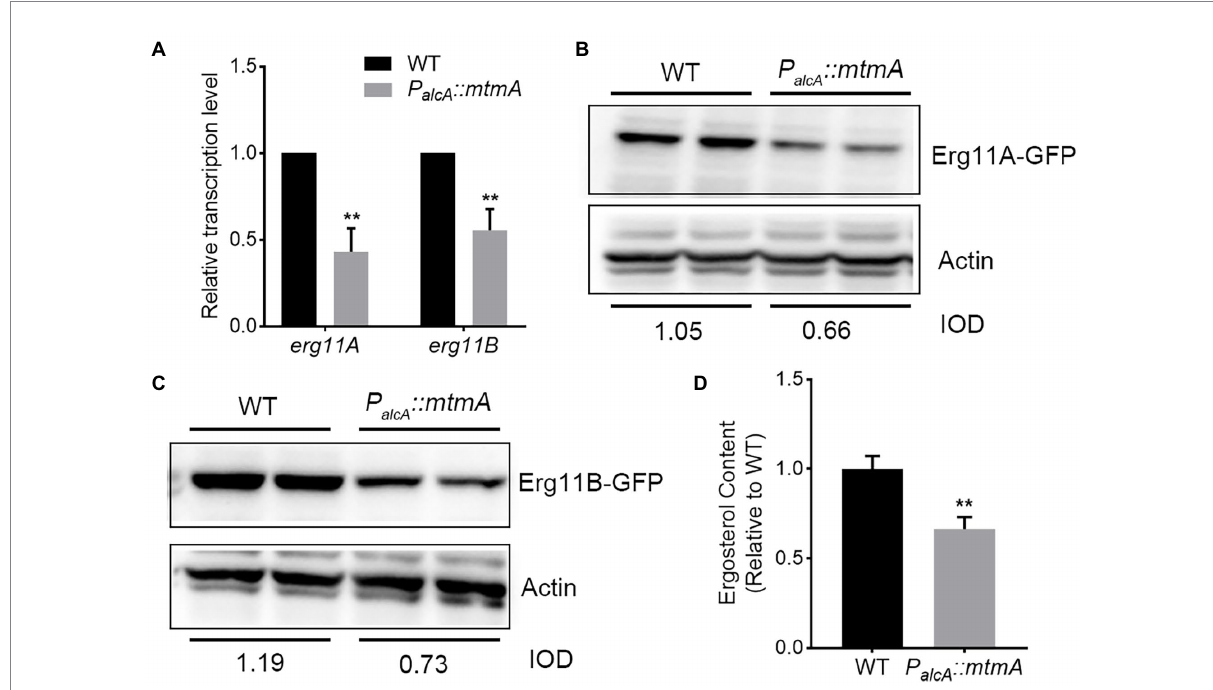
FIGURE 2 MtmA is required for the expression of Erg11A/B. (A) The transcript levels of the indicated genes in WT and the mtmA -repressed strains grown at 37 ° C for 24 h under MM + glucose inhibition culture conditions. Error bars indicate the mean ± SD of the results from three independent experiments. Statistical significance was determined by Student’s t test. **, p < 0.01. (B,C) Western blot analysis of the expression of Erg11A and Erg11B in the parental wild-type and mtmA -repressed strains under MM + glucose inhibition culture conditions. Actin was used as the loading control. The value of the integrated optical density (IOD; IODtarget protein/IODactin) measured by ImageJ indicates the relative protein quantity. (D) The same number of spores from the indicated strains grown for 24 h at 37 ° C in MM + glucose with 0.02 μ g/ml ITC for subsequent ergosterol measurement by HPLC. Values indicate the mean ± SD of the results from three independent experiments. Statistical significance was determined by Student’s t test. **, p <